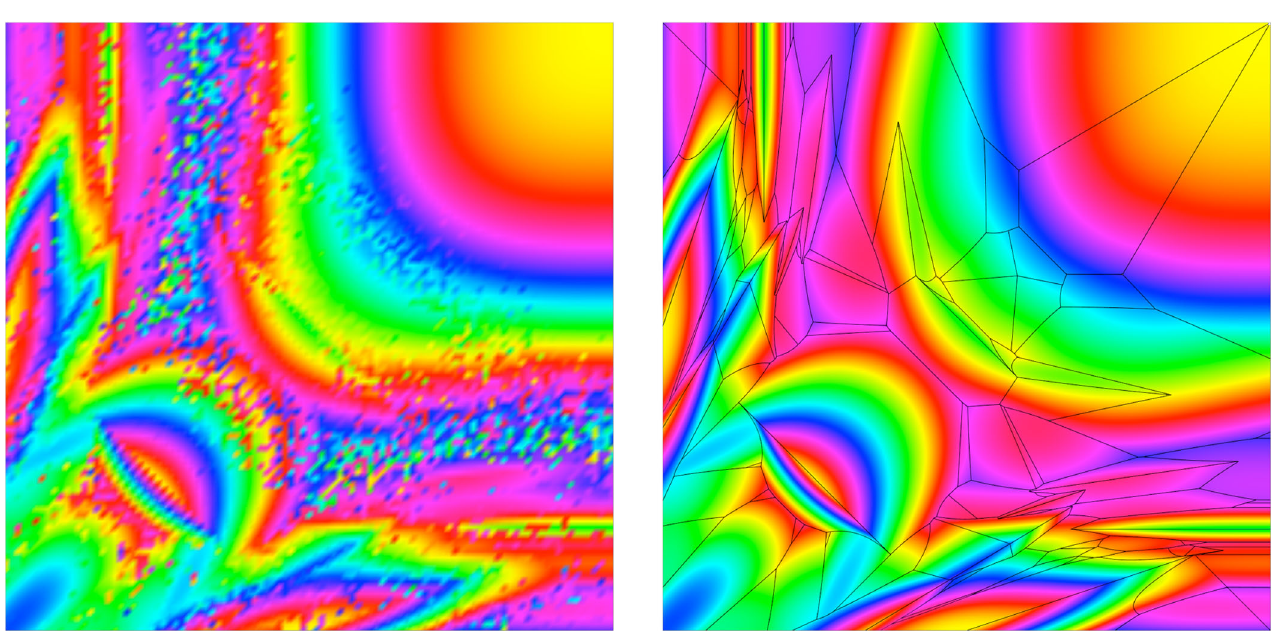
FIG. 17 Contours of optimal packing density ϕ for the 323 · 4 family, numeric (left) versus analytic (right). The color gradient {blue, magenta, red, yellow, green, cyan, and blue} represents the ϕ gradient f ϕ − 3 ϕ þ 2 ; ϕ þ 3 ; yellow contours occur at ϕ ¼ f 9 60 60 g